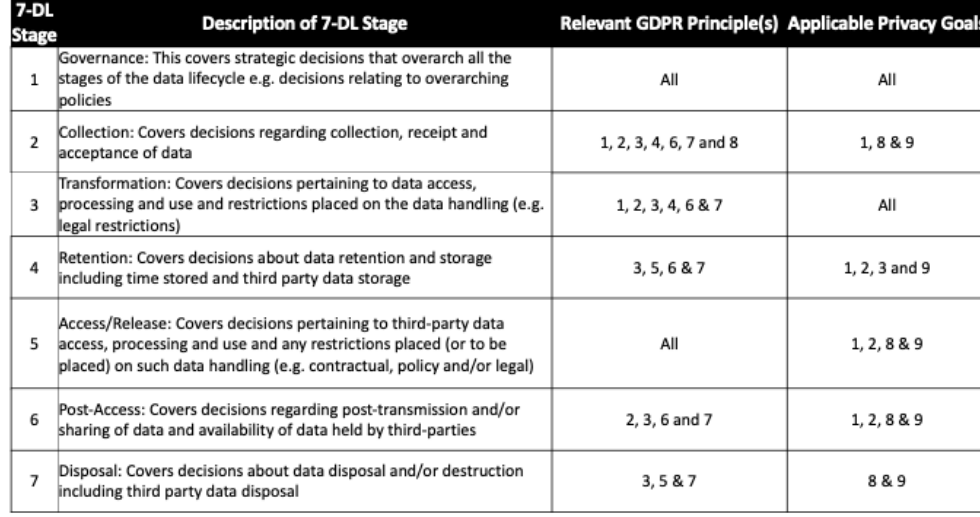
Figure 3. Mapping GDPR principles to 7-DL and the Privacy